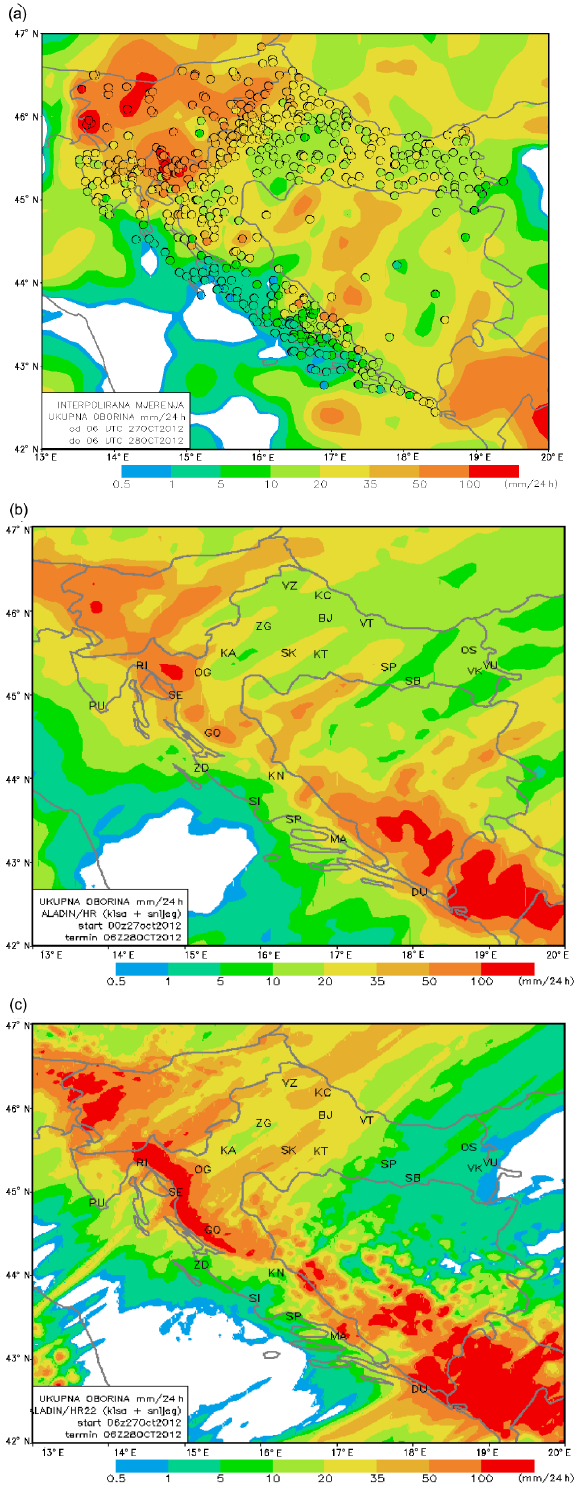
Figure 6. Same as Fig. 5 but for IOP16 (28 October). Figure 7. Same as Fig. 5 but for IOP18 (1